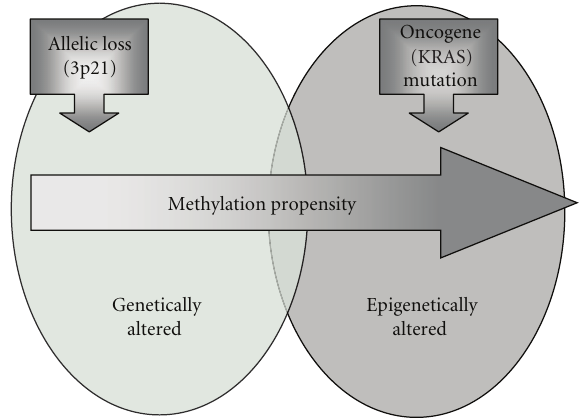
Figure 2: Model of the molecular phenotypes of NSCLC driven by promoter hypermethylation propensity. The model depicts the inverse relationship between epigenetic and genetic alterations and its positive association between epigenetic propensity and growth promoting oncogene